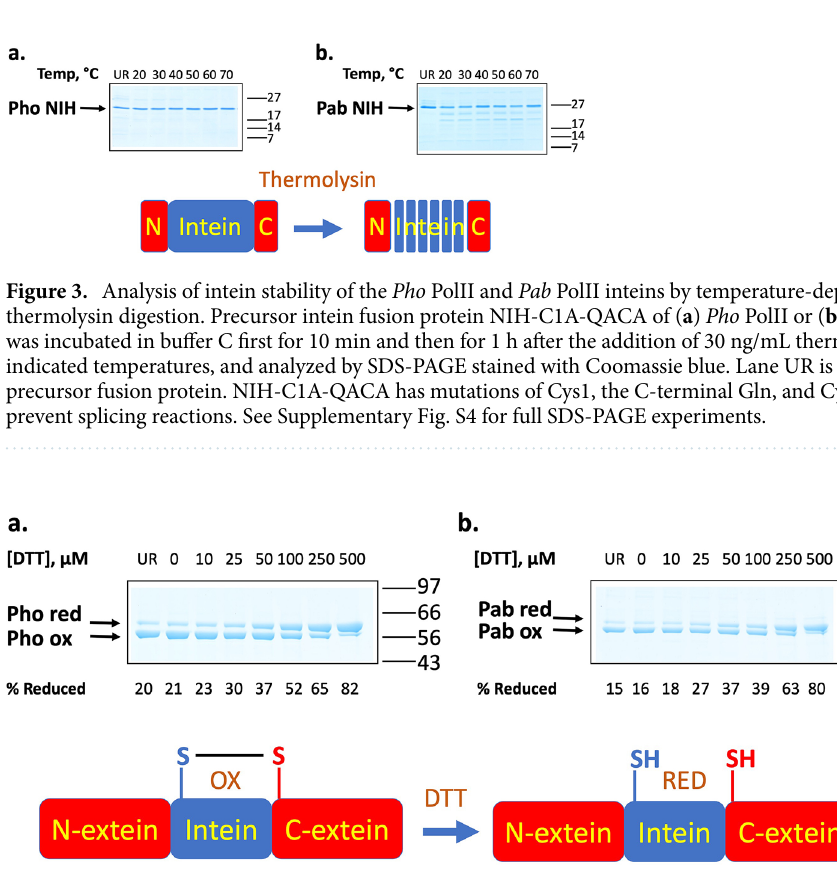
Figure 4. Analysis of disulfide bond strength of the bond between Cys1 and Cys + 1 of the Pho PolII and Pab PolII inteins. Precursor intein fusion protein MIH of the ( a ) Pho PolII or ( b ) Pab PolII intein was incubated with the indicated concentrations of DTT for 30 min at 20 °C, and analyzed by SDS-PAGE without DTT in the loading buffer and stained with Coomassie blue. The percentage of reduced protein was analyzed by densitometry using ImageJ. See Supplementary Fig. S5 for the full SDS-PAGE